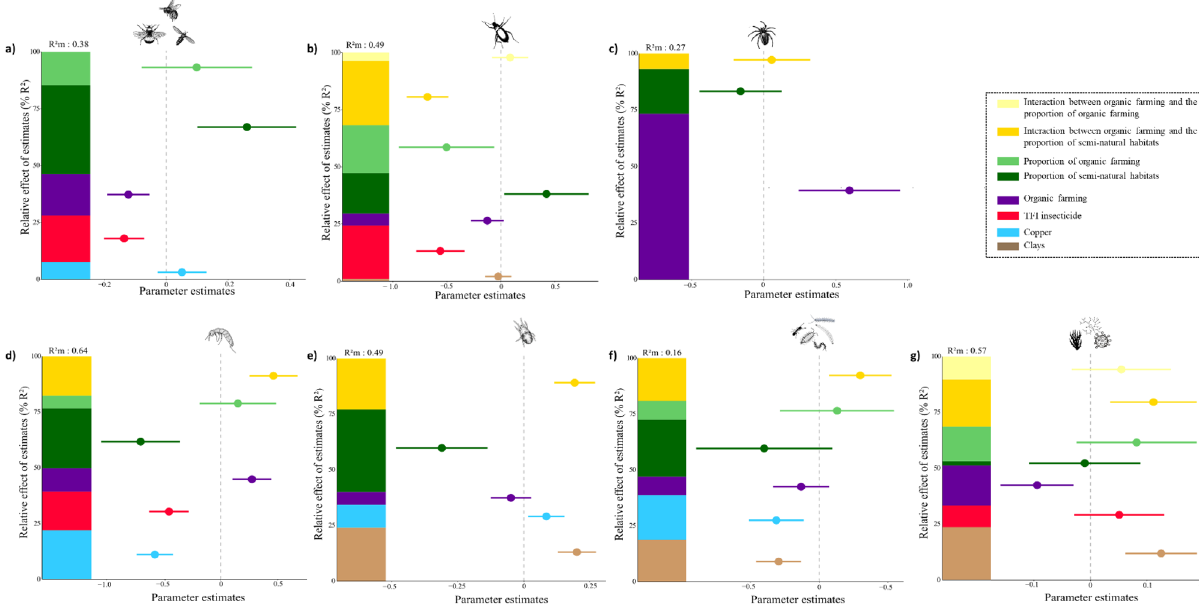
Figure 1. Results of the best models explaining the abundances of (a) pollinators, (b) ground beetles, (c) spiders, (d) springtails, (e) mites, (f) soil microarthropods and (g) microbial biomass according to the type of farming system (organic or conventional), landscape context, farming practices independent of farming systems and soil characteristics. Stacked bars show the relative effects of estimates (%R 2 ) for each explanatory variable calculated as the ratios between the parameter estimates and the sum of all parameter estimates based on a model averaging approach applied to model 1. Points are estimates of the model coefficients, and lines represent confidence intervals. All continuous predictors were scaled to interpret parameter estimates at comparable scales. All individual plots representing the effects of significant explanatory variables of Fig. 1 are provided as supplementary material (Fig S1-S8). Note that results of best models for models 2 explaining abundances of the different groups by specific farming practices, landscape context and soil characteristics are provided in Figure S10. This figure was made using R version 4.0.3 (https:// www.R- proje ct. org/) and Inkscape 1.0 (www. inksc ape.